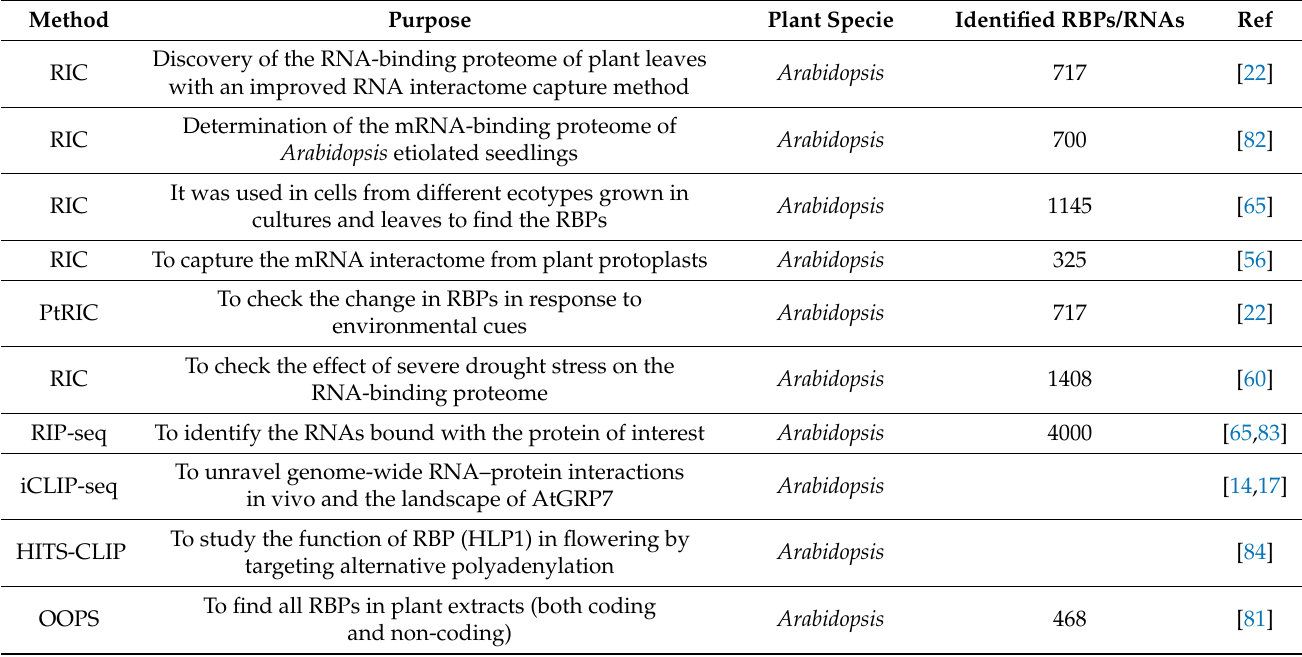
Table 2. All earlier ribonomics approaches devised in mammals and applied in